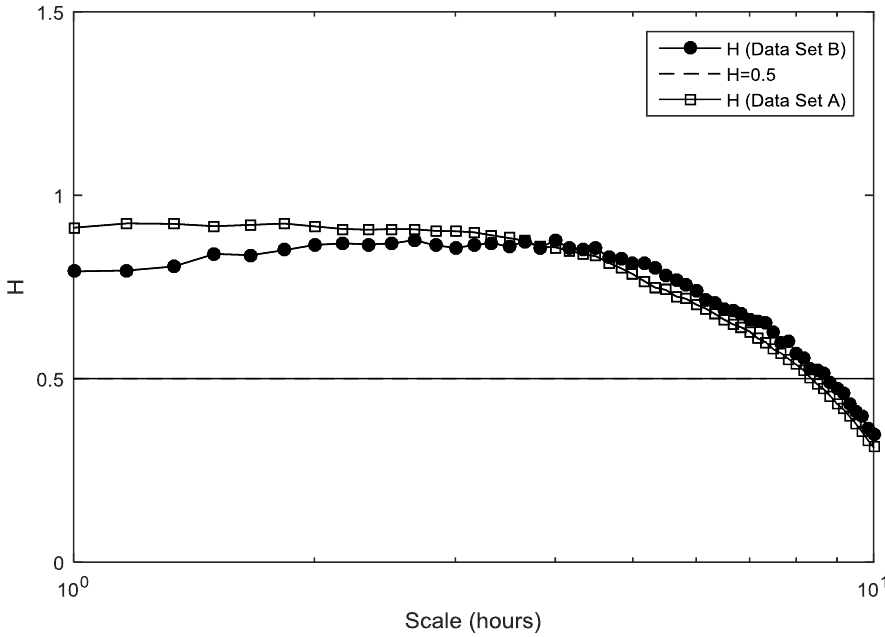
Figure 9. Spectrum of H values as a function of temporal scale for the two data sets. The dotted line at H = 0.5 denotes complete randomness and zero predictability.